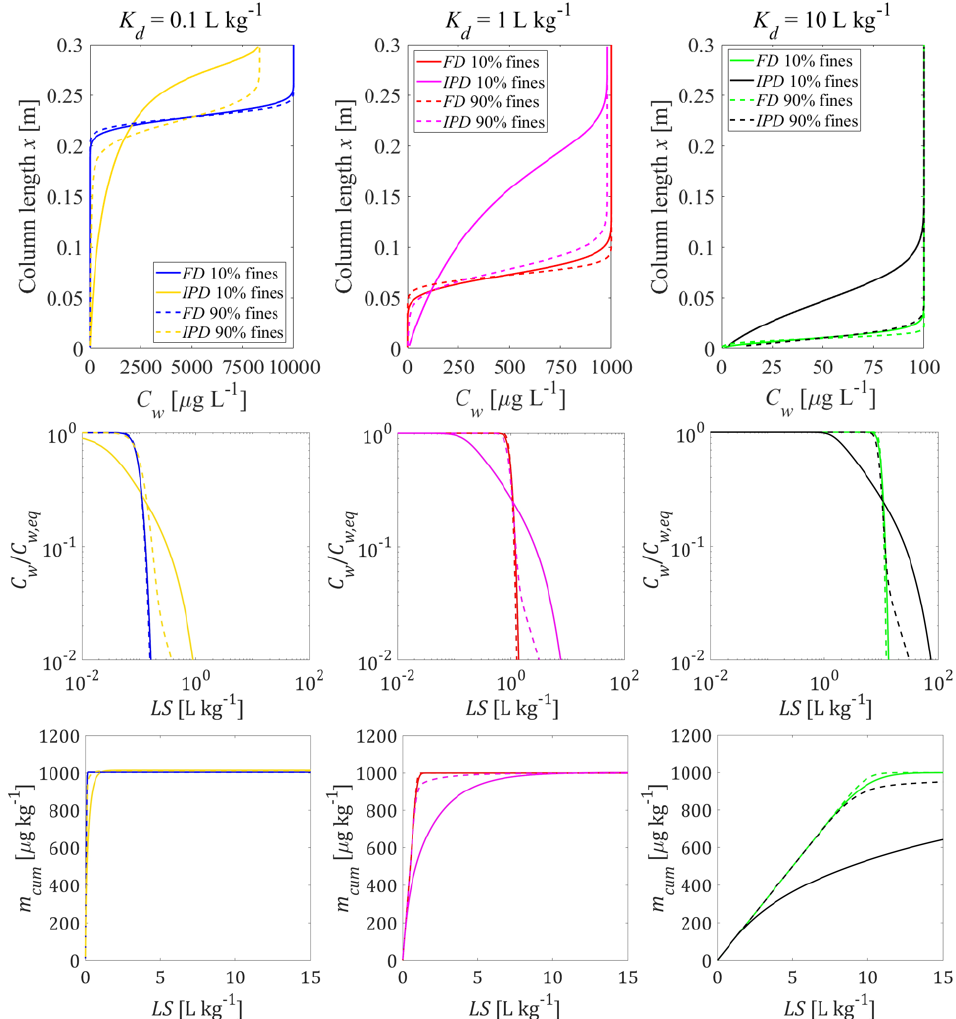
Figure 10. Behavior of the bi-modal material compositions of fine and coarse particles: initial concentration distribution in the column after the first flooding ( top panel ) and column effluent concentration (normalized: mid panel , cumulative: bottom panel ) vs. time (expressed as liquid to solid ratio: LS ); solid lines: fine particle mass fraction 10%; dashed lines: fine particle mass fraction 90%. ( n = 0.45, v = 1.67 × 10 − 5 m s − 1 , α = 0 (no dispersion), C s , ini = 1000 µ g kg − 1 , t c = 5 h, D aq = 1 × 10 − 9 m 2 s − 1 , ε = 0.05, d p , coarse = 2000 µ m, d p , fine = 63 µ